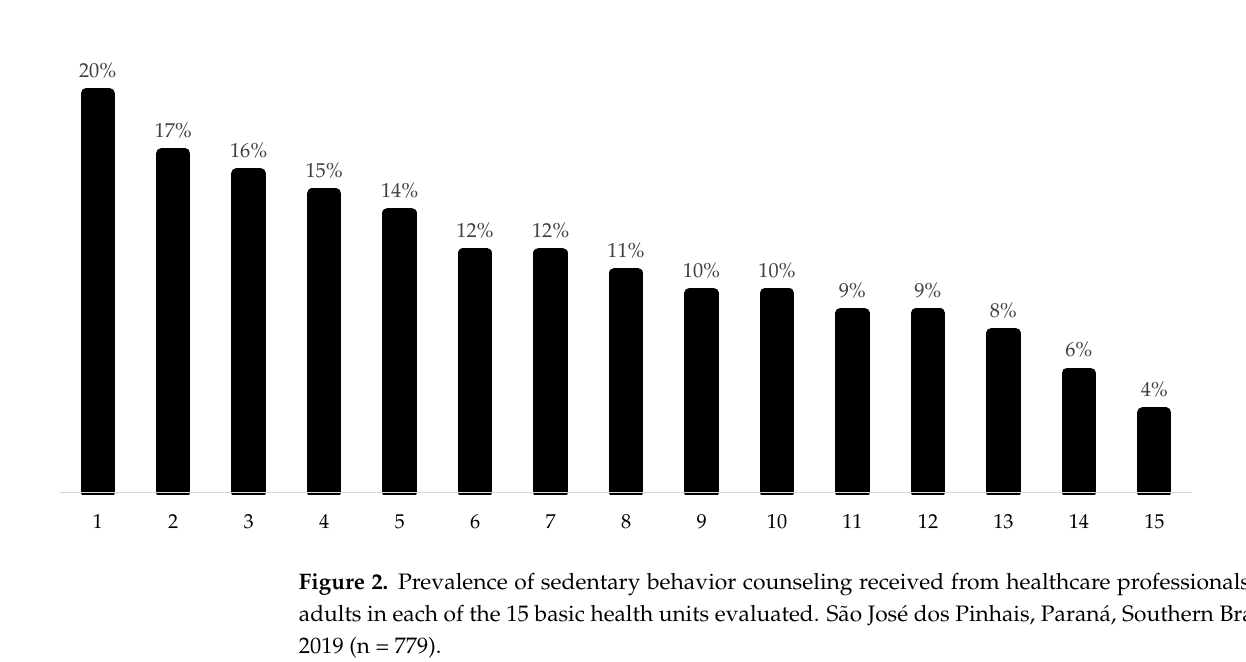
Figure 1. Prevalence of chronic disease of adults attending basic health units. São José dos Pinhais, Paraná, Southern Brazil, 2019 (n = 779).